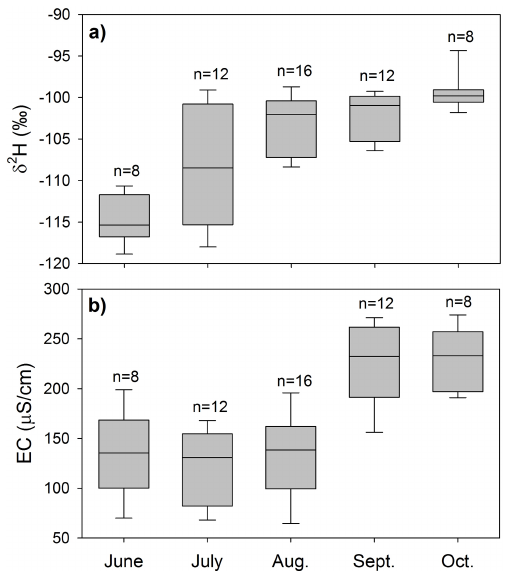
Figure 8. Box-plot of δ 2 H (a) and EC (b) of stream water data collected at the same time at the four selected locations along the Saldur River (S1, S3-LSG, S5 and S8) in 2011, 2012 and 2013 and grouped according to the sampling month. The whiskers represent the 10th and 90th percentiles, the box limits indicate the 25th and 75th percentiles and the line within the box marks the median.